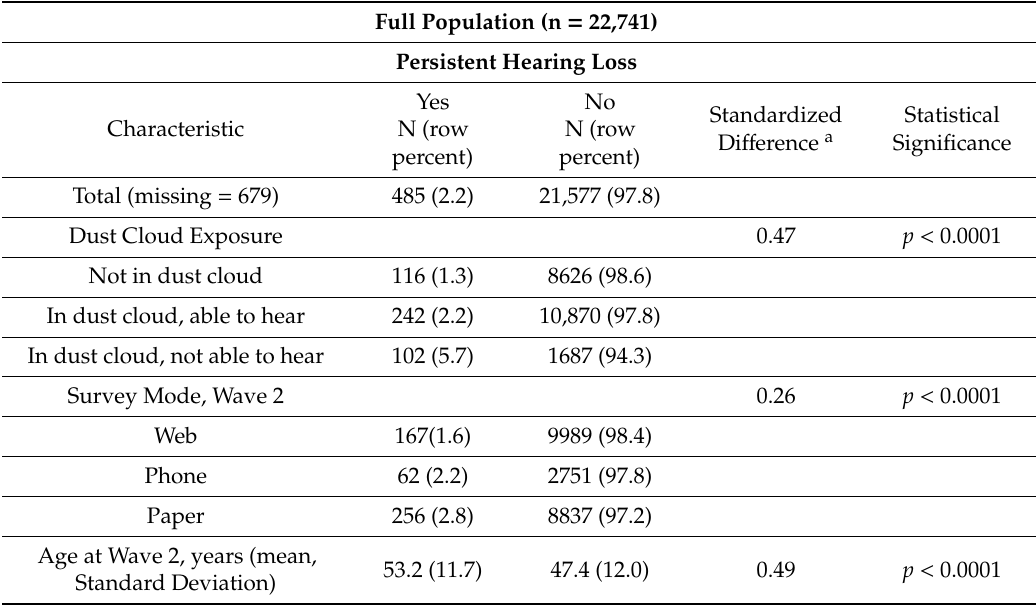
Table 1. Characteristics of World Trade Center Health Registry community enrollees by persistent self-reported hearing problems a ,